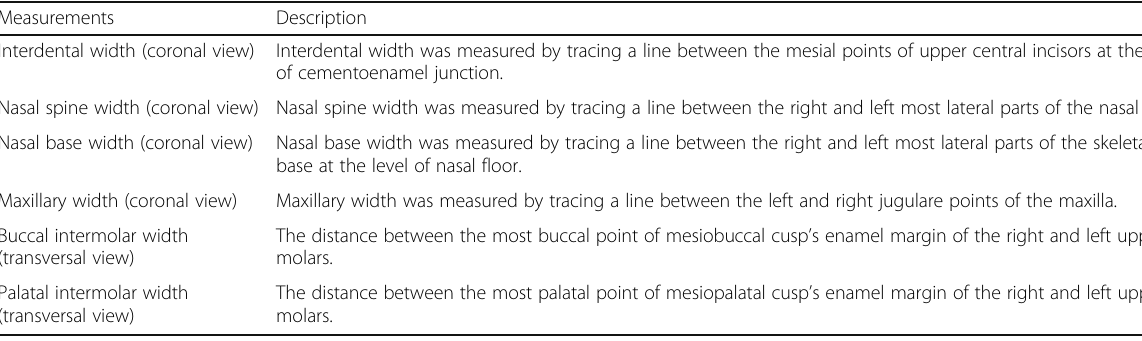
Table 1 Description of the measurements Measurements Description Interdental width (coronal view) Interdental width was measured by tracing a line between the mesial points of upper central incisors at the level of cementoenamel junction. Nasal spine width (coronal view) Nasal spine width was measured by tracing a line between the right and left most lateral parts of the nasal spine. Nasal base width (coronal view) Nasal base width was measured by tracing a line between the right and left most lateral parts of the skeletal nasal base at the level of nasal floor. Maxillary width (coronal view) Maxillary width was measured by tracing a line between the left and right jugulare points of the maxilla. Buccal intermolar width (transversal view)